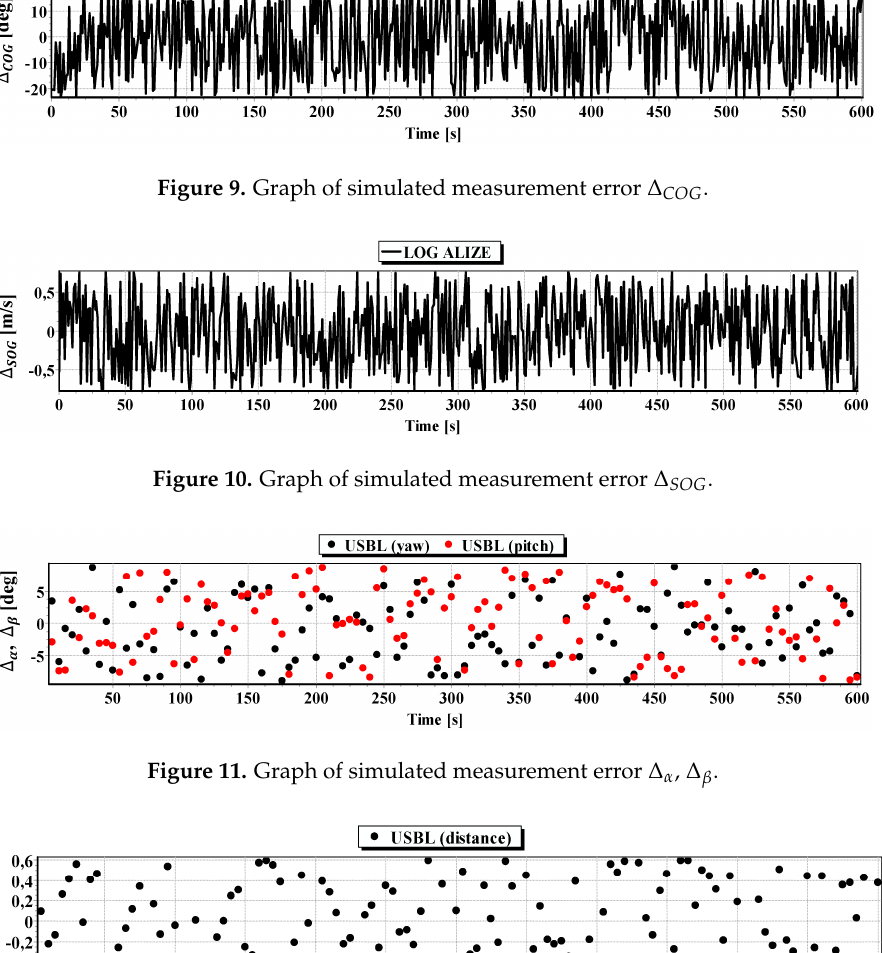
Figure 12. Graph of simulated measurement error ∆ (cid:3045) .